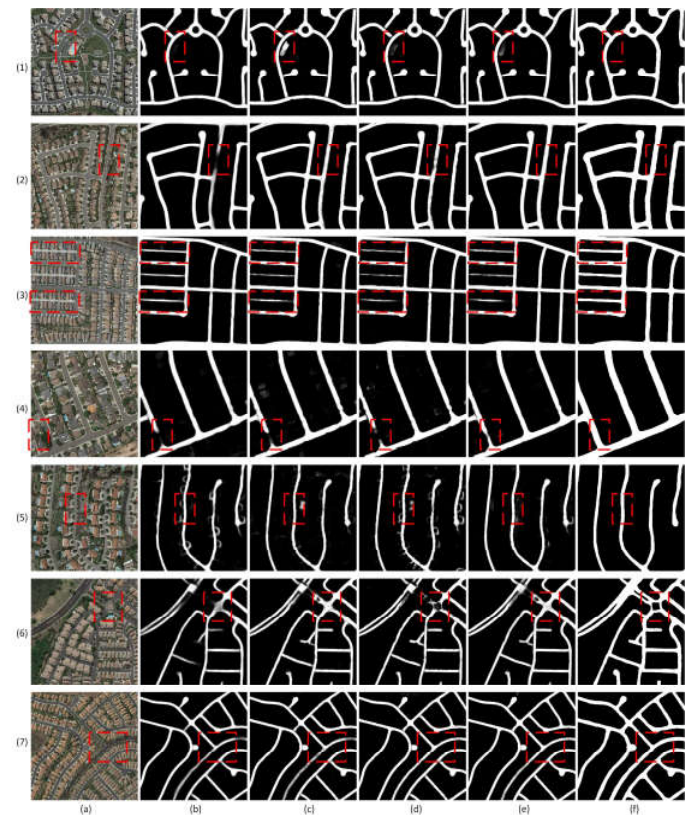
Figure 10. Comparison of road extraction results on NLPR road datasets: ( a ) Input Image. ( b ) Result from CasNet. ( c ) Result from U-Net. ( d ) Result from Res-U-Net. ( e ) Result from JointNet. ( f ) Ground truth.